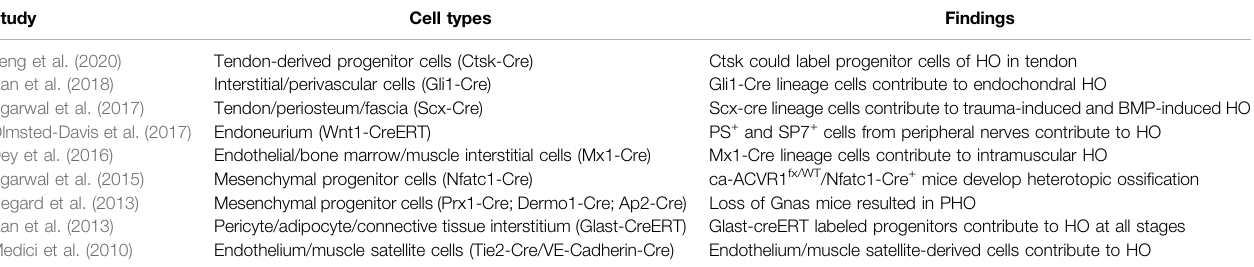
TABLE 1 | Cells types contributing to heterotopic ossi fi